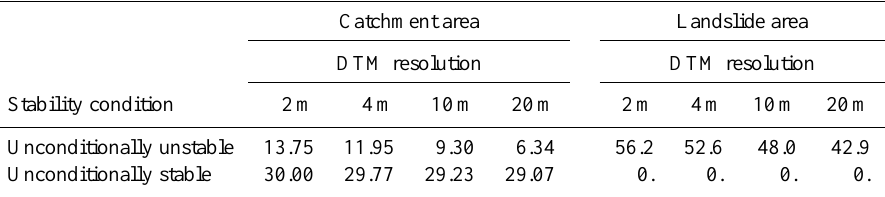
Table 3. Percentages of catchment area and of observed landslide area considered either unconditionally unstable or unconditionally stable with the QD-SLaM application and for the DTM resolution of 2, 4, 10, and 20m.